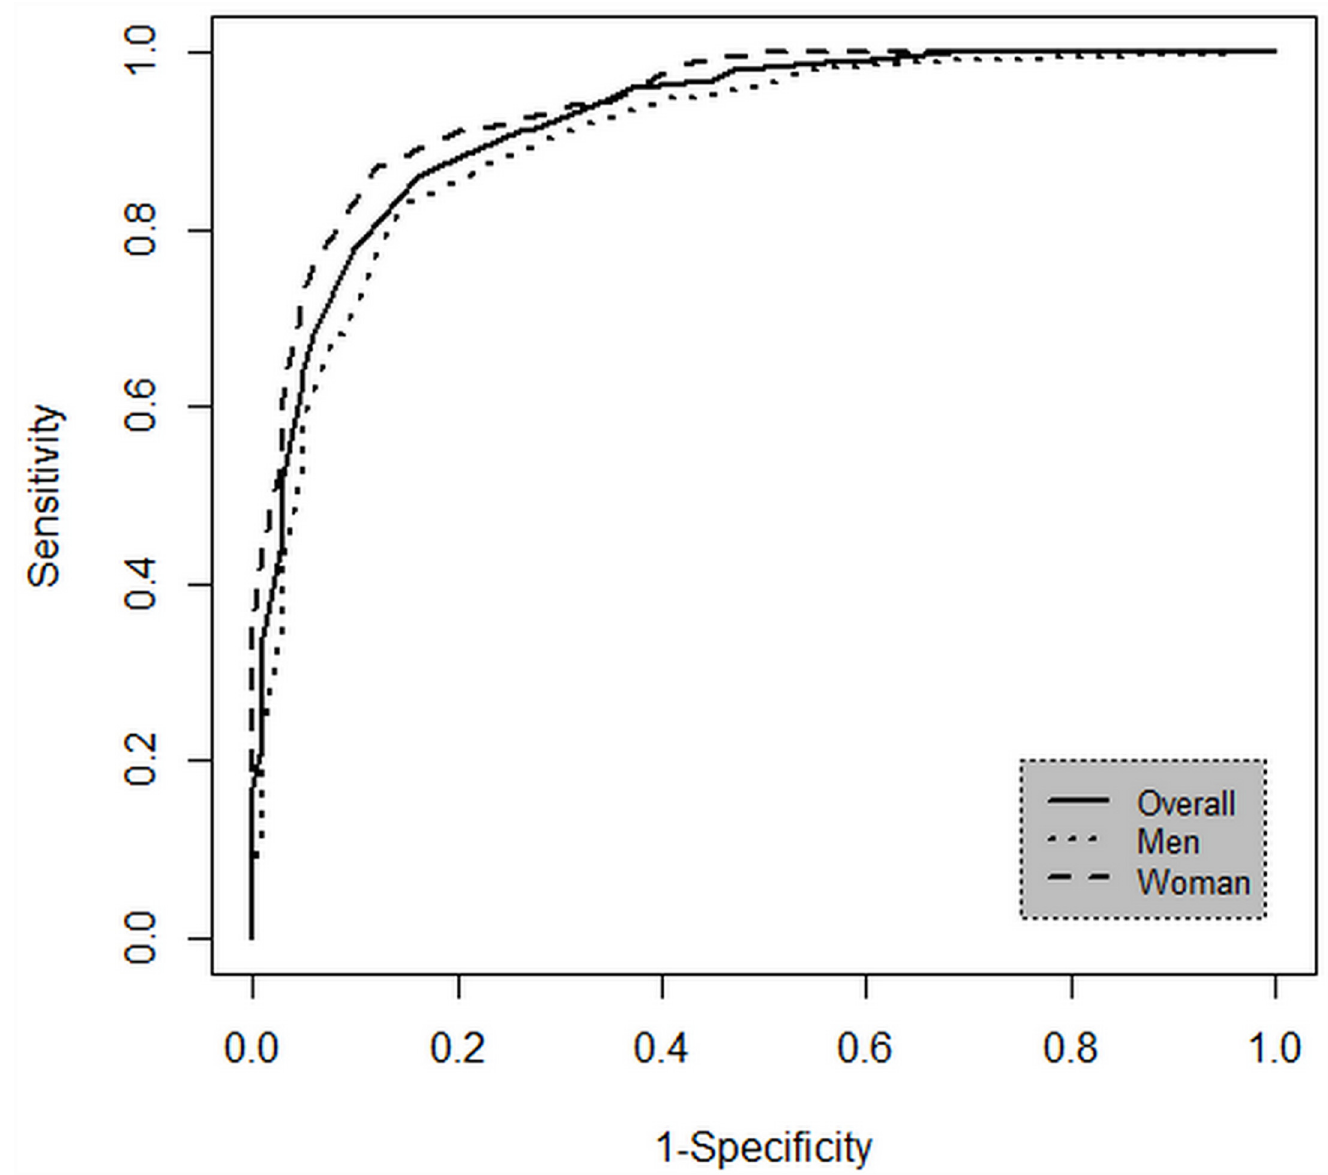
Fig 3. Area Under the Curve of Mid-Upper Arm Circunference for the detection of malnutrition in the whole sample and stratified by sex.